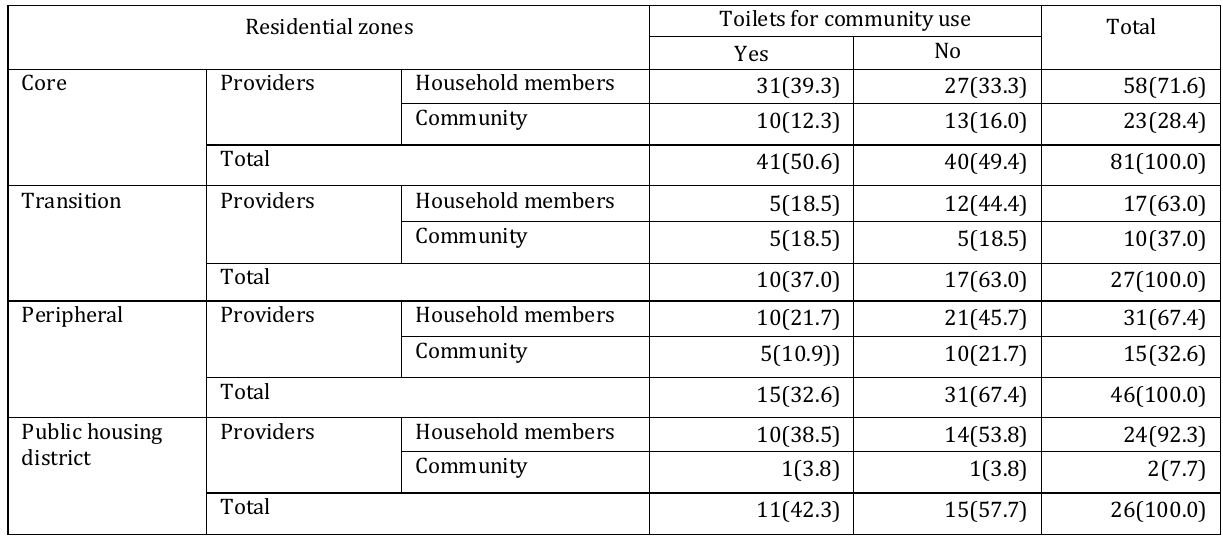
Table 5. Providers of toilet facilities across residential zones